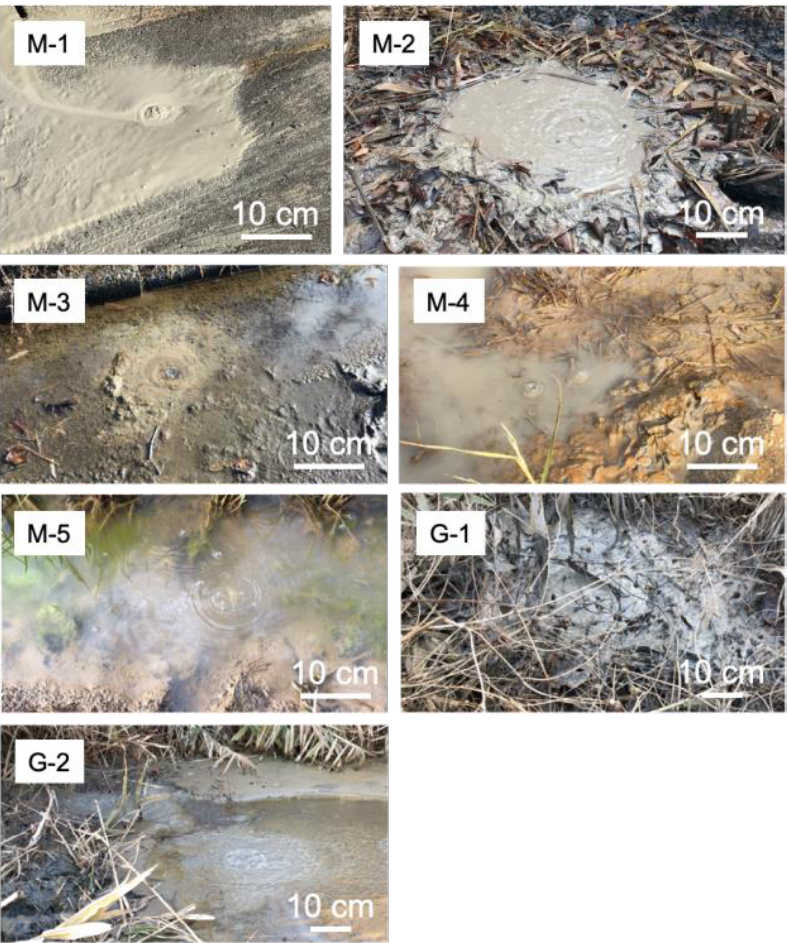
Figure 2. Pictures taken at the 7 sampling points indicated in Figure 1. The sampling points (M-1, M-2, M-3, M-4, M-5, G-1 and G-2) are those described in Figure 1.